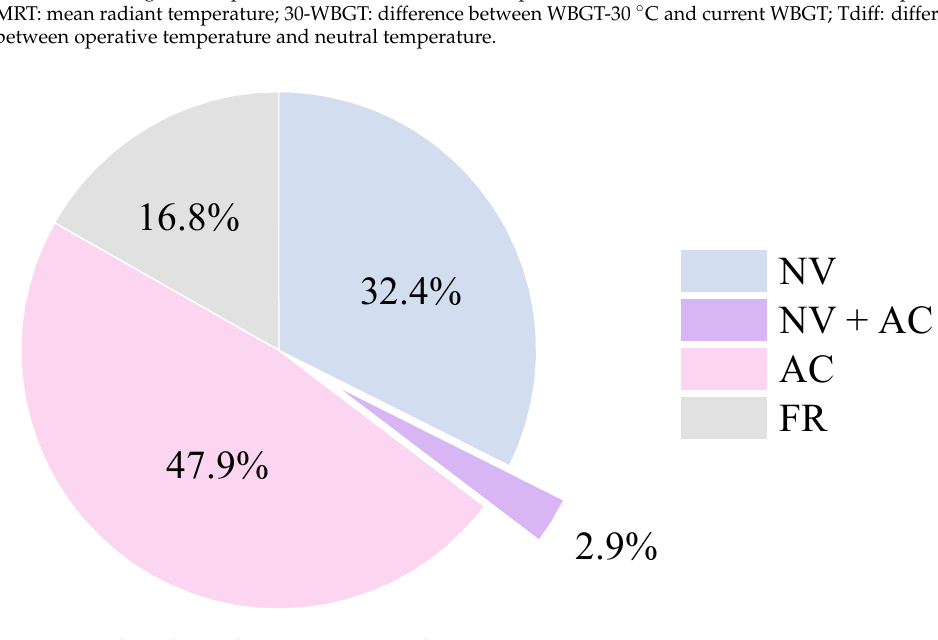
Figure 4. Indoor thermal environment conditions. Table 6. Statistical summary of subjective votes.